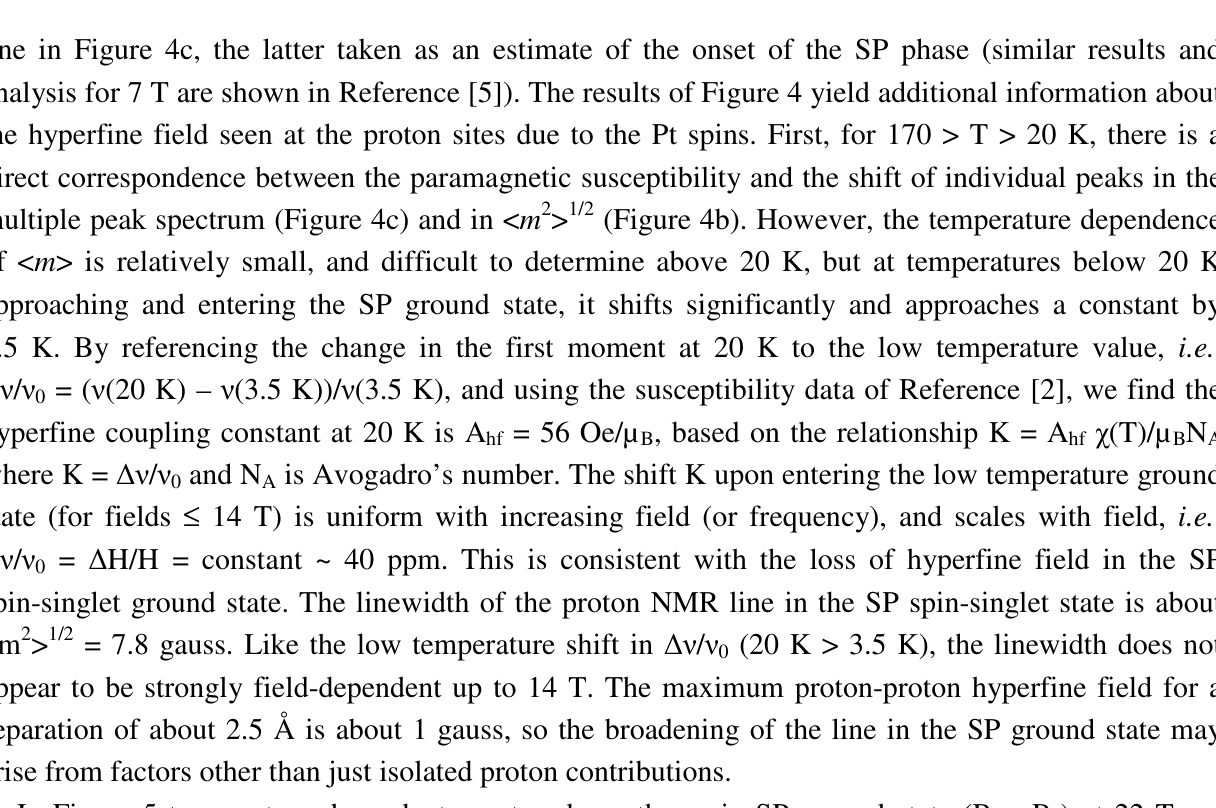
[Pt(mnt) ] above the SP critical 2 2